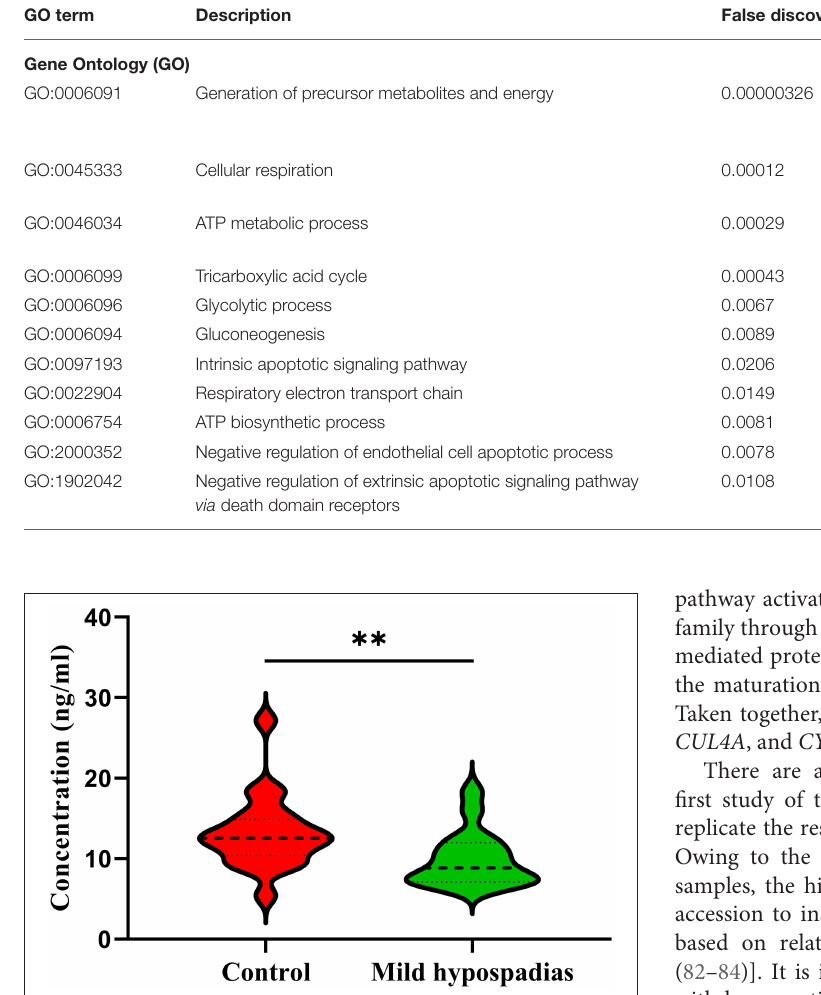
FIGURE 5 | Validation of cytochrome C by ELISA. Cytochrome C was found in significantly lower concentrations in mild hypospadias samples (median = 8.86ng/ml) in comparison to controls (median = 12.56ng/ml) samples in agreement with proteomics results. Dashed line represents the median value. Dotted lines represent quartiles, top: 75% percentile and bottom: 25% percentile. ** = p < 0.05. Controls, n = 10; Mild hypospadias, n =